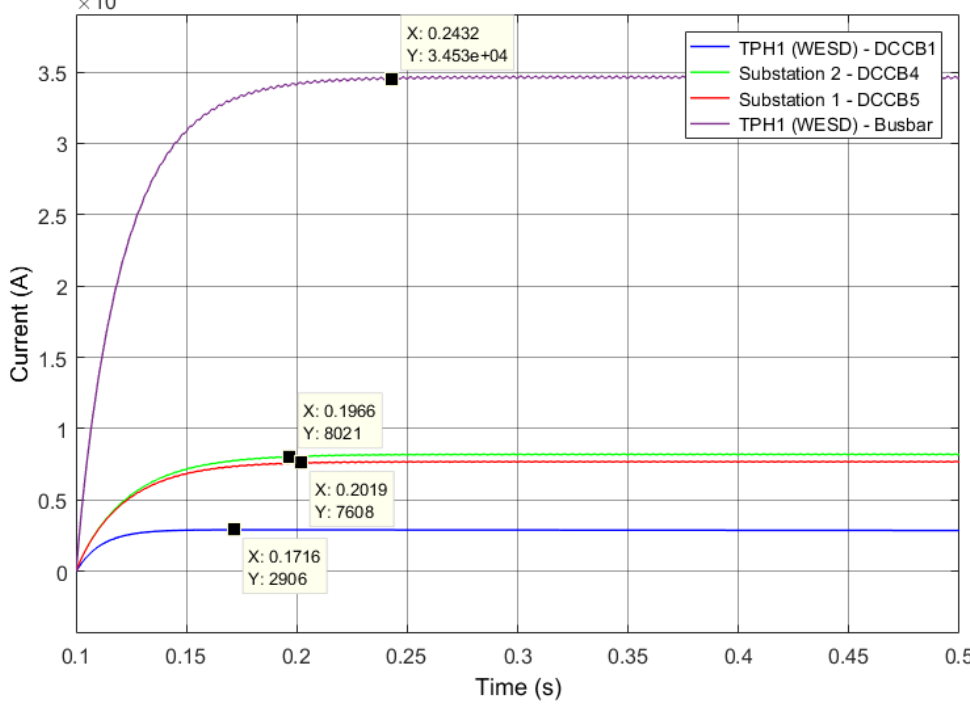
Figure 13. Simulation results of Scenario F1. Fault current (A) vs. time (s) observed with the DCCB4 (Substation 1—blue), DCCB1 (Substation 1—red), and DCCB4 (TPH1—green). F2 modeled a bolted fault at the TPH DC busbar. Figure 14 shows that the short-circuit maximum value at the DC busbar had a value of 34.5 kA.